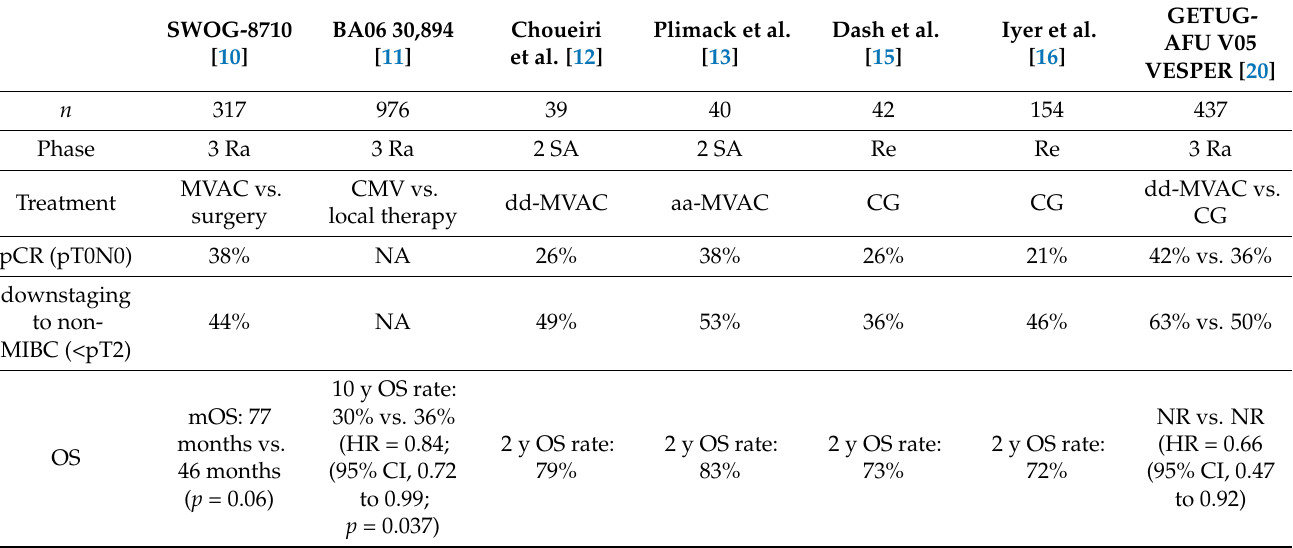
Table 1. Summary of trials for neoadjuvant chemotherapy in